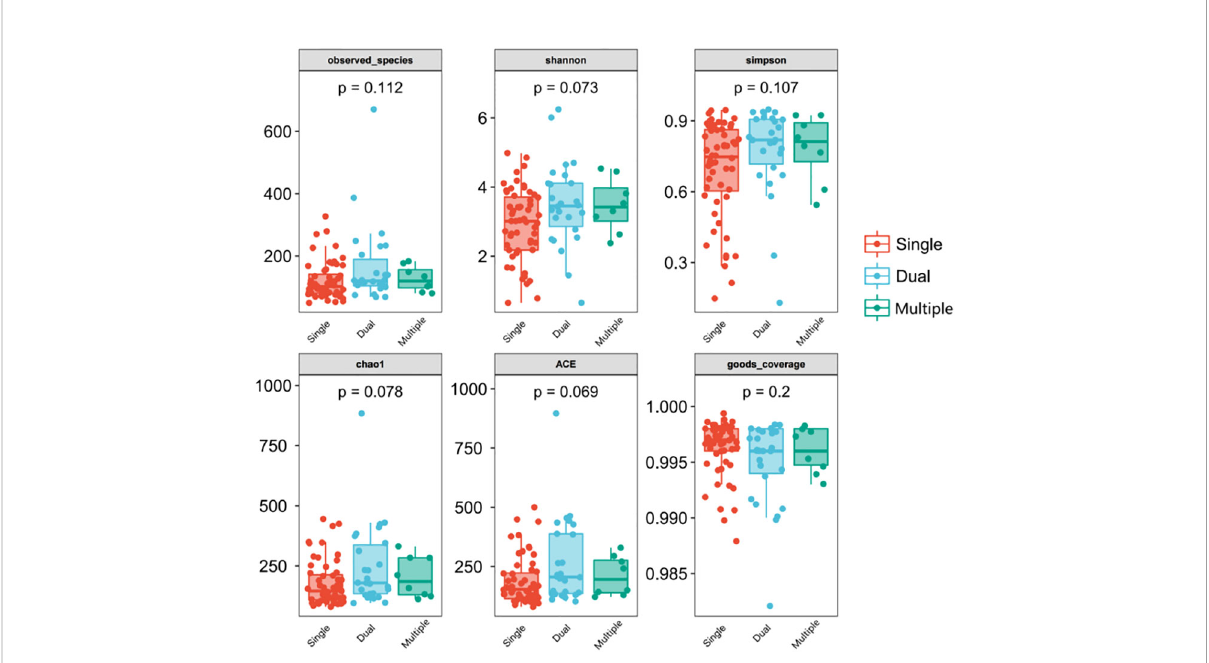
FIGURE 7 Comparison between alpha diversity index (observed - species, Shannon, Simpson, Chao1, ACE, good-coverage) of infected and healthy individuals. The p -value on the top indicates the overall difference among three groups calculated using the Kruskal-Wallis nonparametric test method, and the asterisks on the top indicate a statistically signi fi cant difference between the two groups calculated using Dunn ’ s test (* p < 0.05, ** p < 0.01). Single (n = 56): infected with a single HPV subtype; dual (n = 26): infected with two HPV subtypes; Multiple (n = 8): infected with three or more HPV